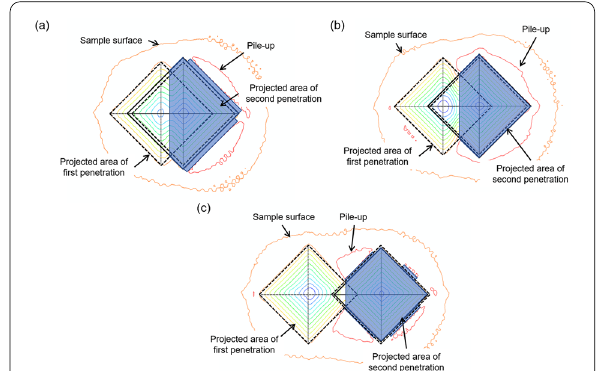
Figure 5 Schematic of projected area of the contact area between the two adjacent indentations with spacings of a 1 μm, b 2 μm